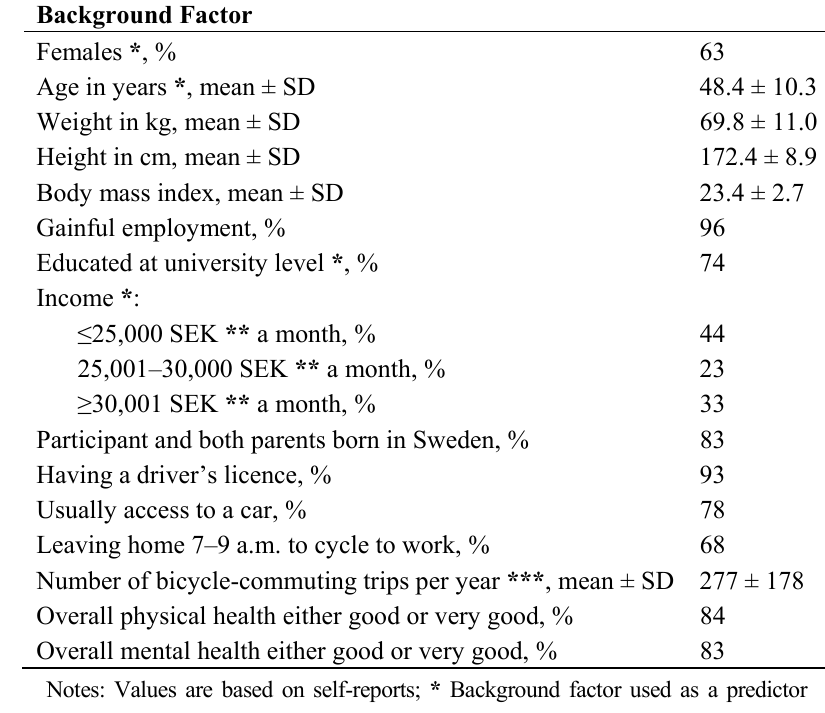
Table 1. Background factors of participants (n =